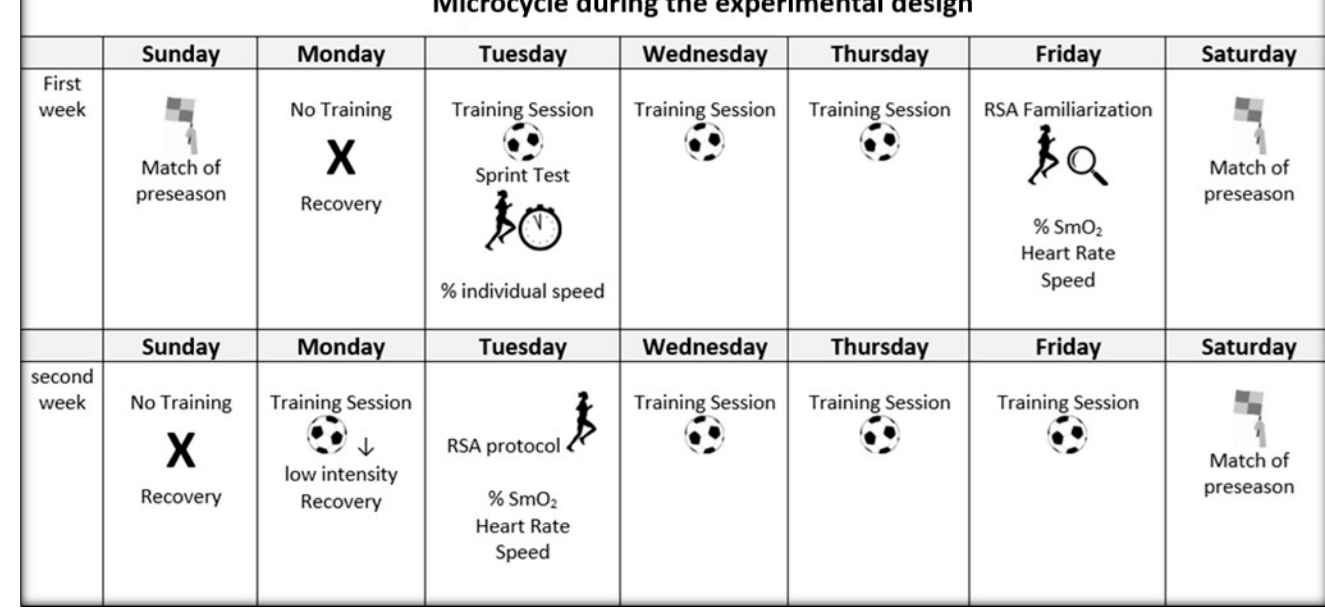
Figure 1. Description of the preseason micro-cycle and RSA protocol measurements in women soccer players.